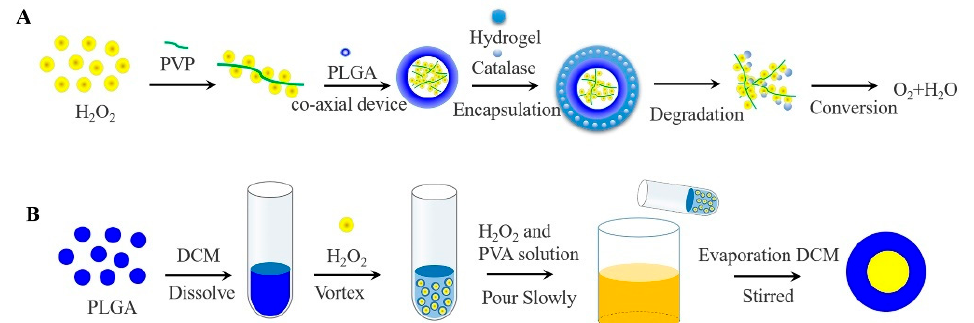
Figure 4. ( A ) Oxygen generating systems were fabricated via the coaxial device, with PLGA as the outer shell, H 2 O 2 and PVP complexes as the core. While the released H 2 O 2 was converted to oxygen and water by contacting with catalase in the thermosensitive hydrogel. ( B ) Schematic of the W 1 /O/W 2 method for the preparation of PLGA-H 2 O 2 microspheres.